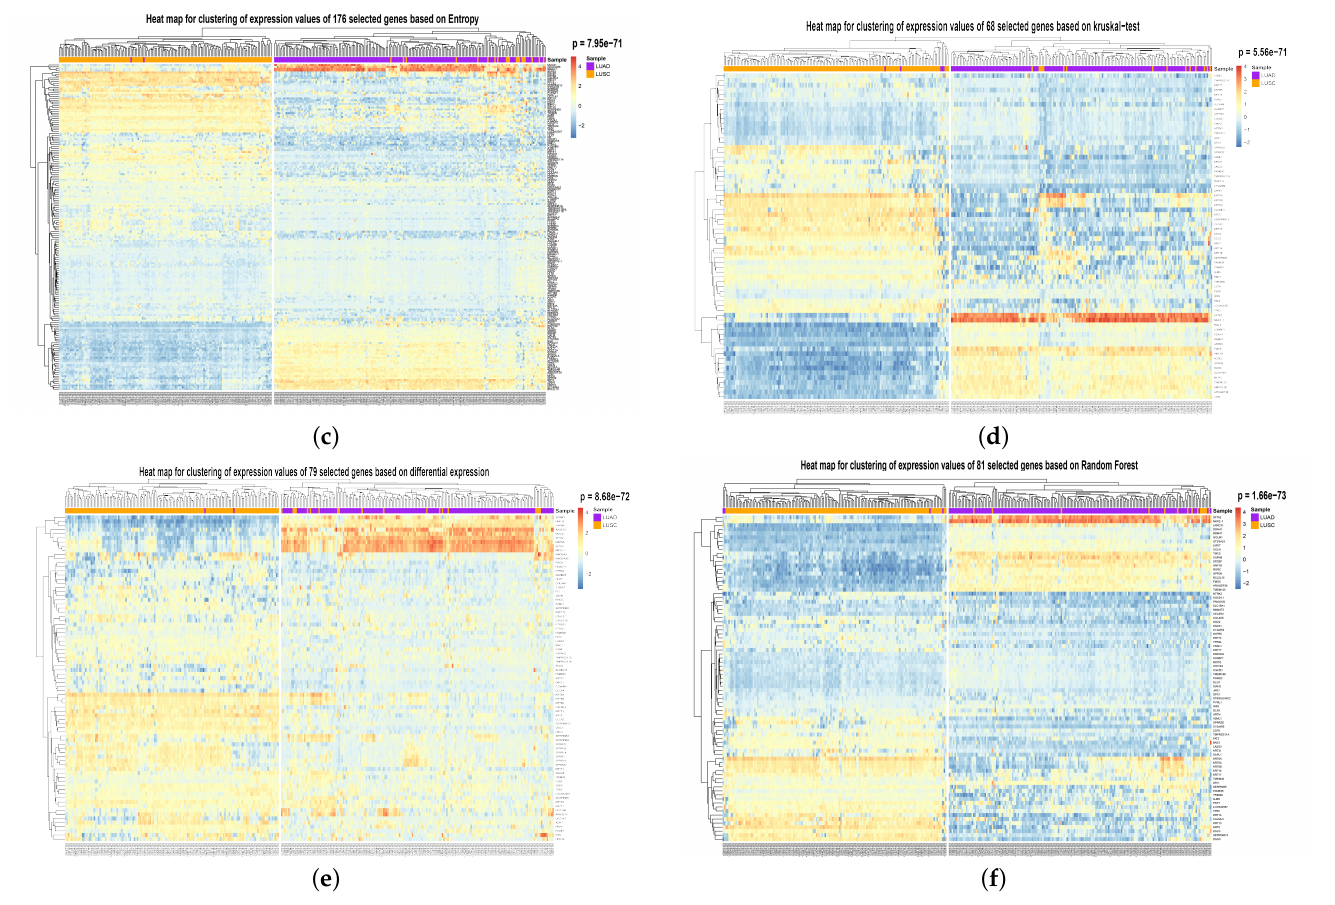
Figure 6. Heat map of gene expression clustering for genes selected by six different methods. ( a ) The heat map of HSSG-selected gene expression clustering. ( b ) The heat map of Variance-selected gene expression clustering. ( c ) The heat map of Entropy-selected gene expression clustering. ( d ) The heat map of Kruskal-test-selected gene expression clustering. ( e ) The heat map of Differential expression- selected gene expression clustering. ( f ) The heat map of Random Forest-selected gene expression